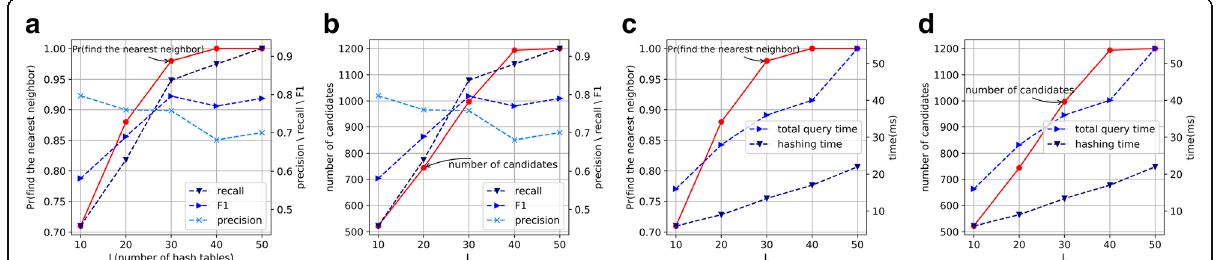
Fig. 5 The effect of the number of hash table L on the algorithm. a L versus the probability of find the nearest neighbor and precision/recall/F1. b L versus the number of candidates and precision/recall/F1. c L versus the probability of find the nearest neighbor and query/hashing time. d L versus the number of candidates and query/hashing